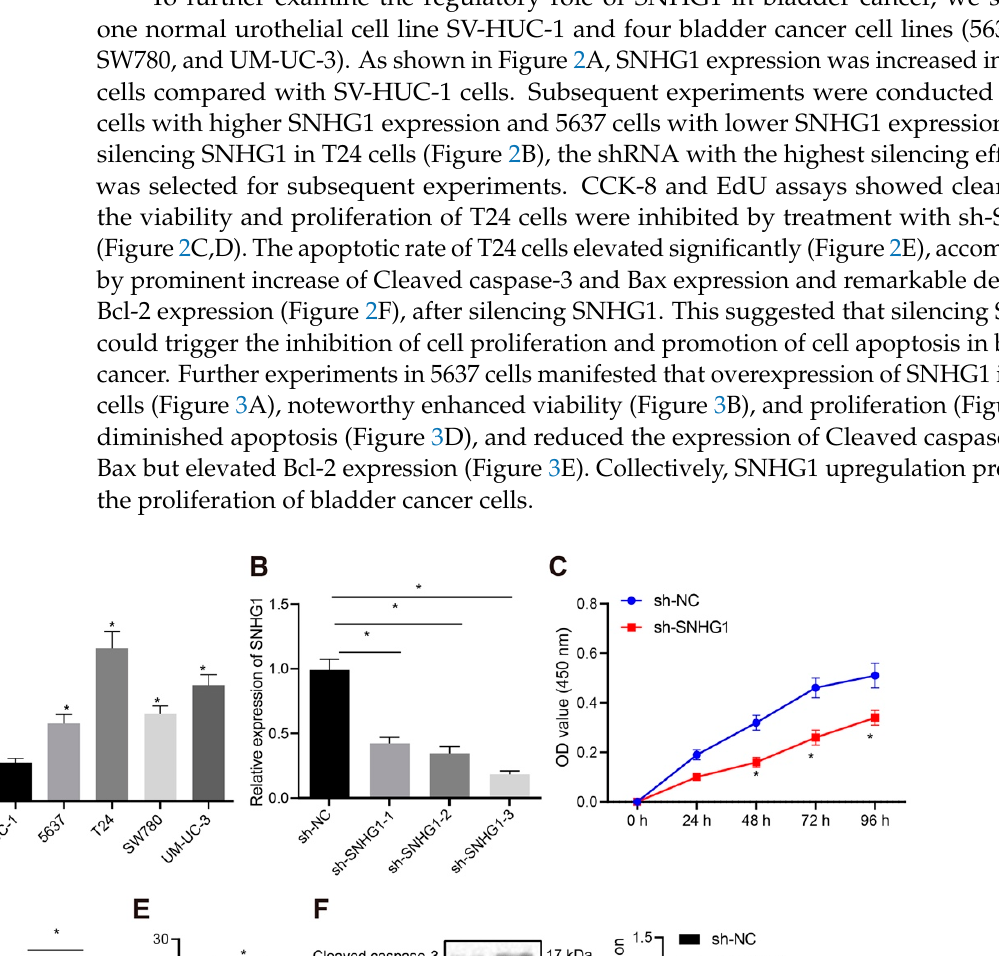
Figure 3. Overexpression of SNHG1 stimulates bladder cancer cell proliferation and represses cell apoptosis. ( A ) qRT-PCR determination of the overexpression efficiency of oe-SNHG1 in 5637 cells.